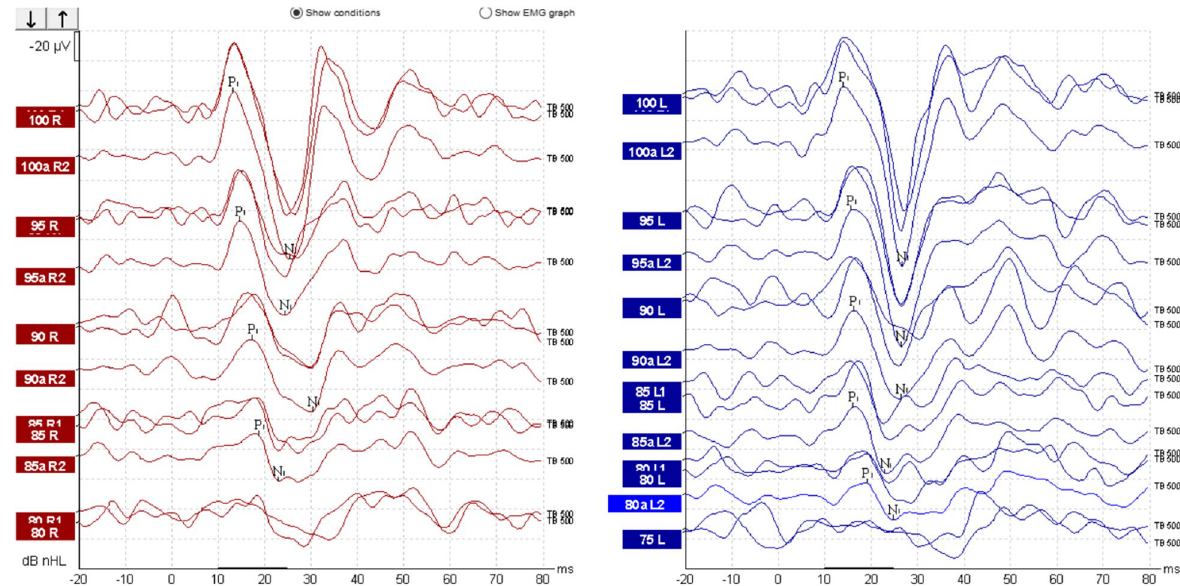
Fig. 1 Record of mVEMP mVEMPs responses were obtained from a female individual. (mVEMPs responses, right ear VEMPs threshold 85 dB nHL, left